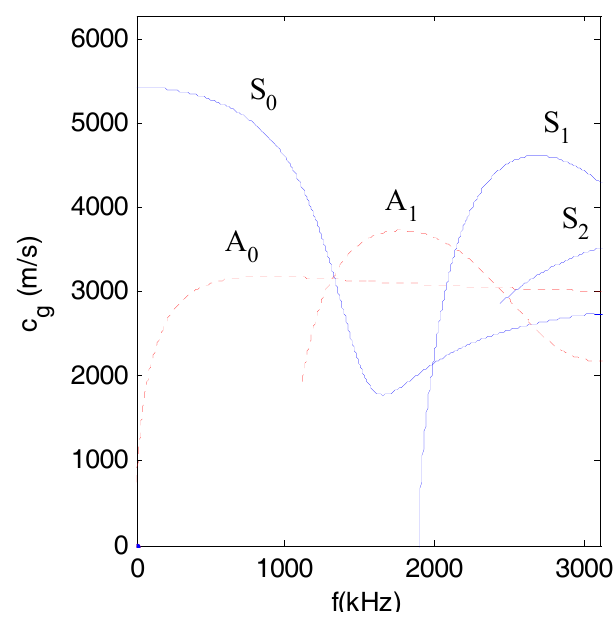
Figure 1. Dispersive curve of group velocity (Alloy 5052, half-depth h = 0.75mm).